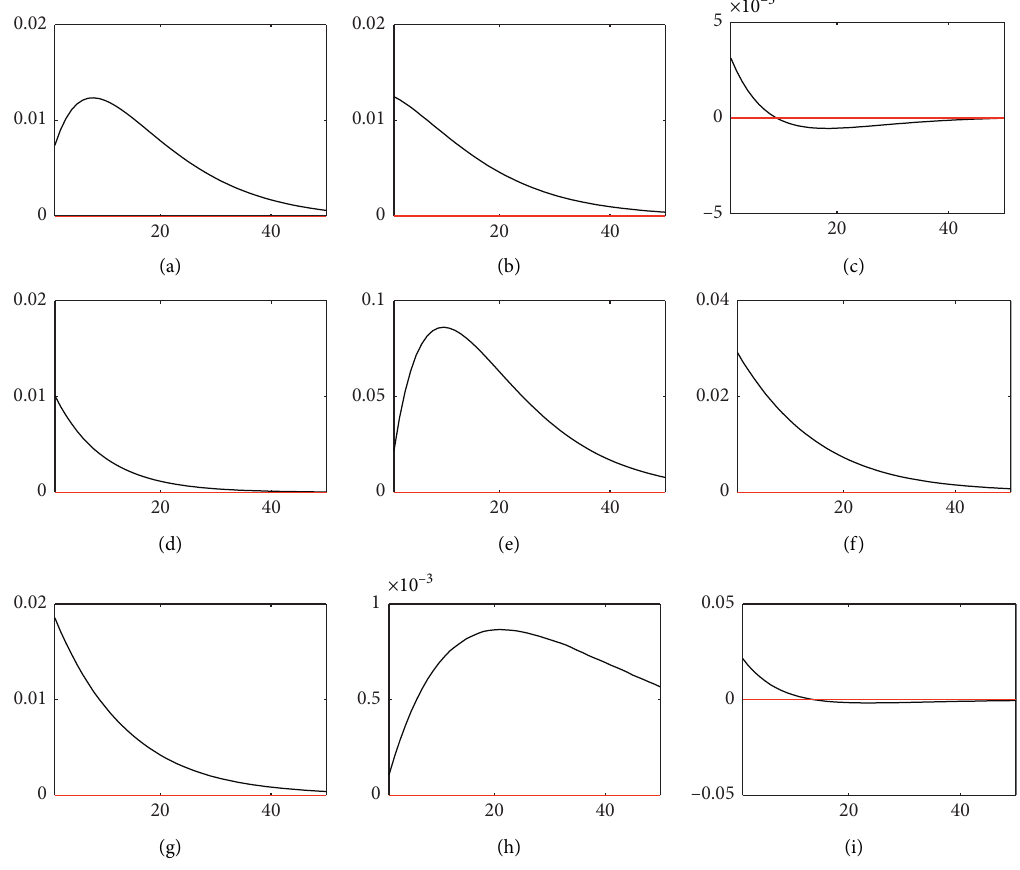
Figure 2: Impulse response to a technology shock. (a) C . (b) W . (c) N . (d) A . (e) K . (f) Y . (g) Z . (h) G . (i) I